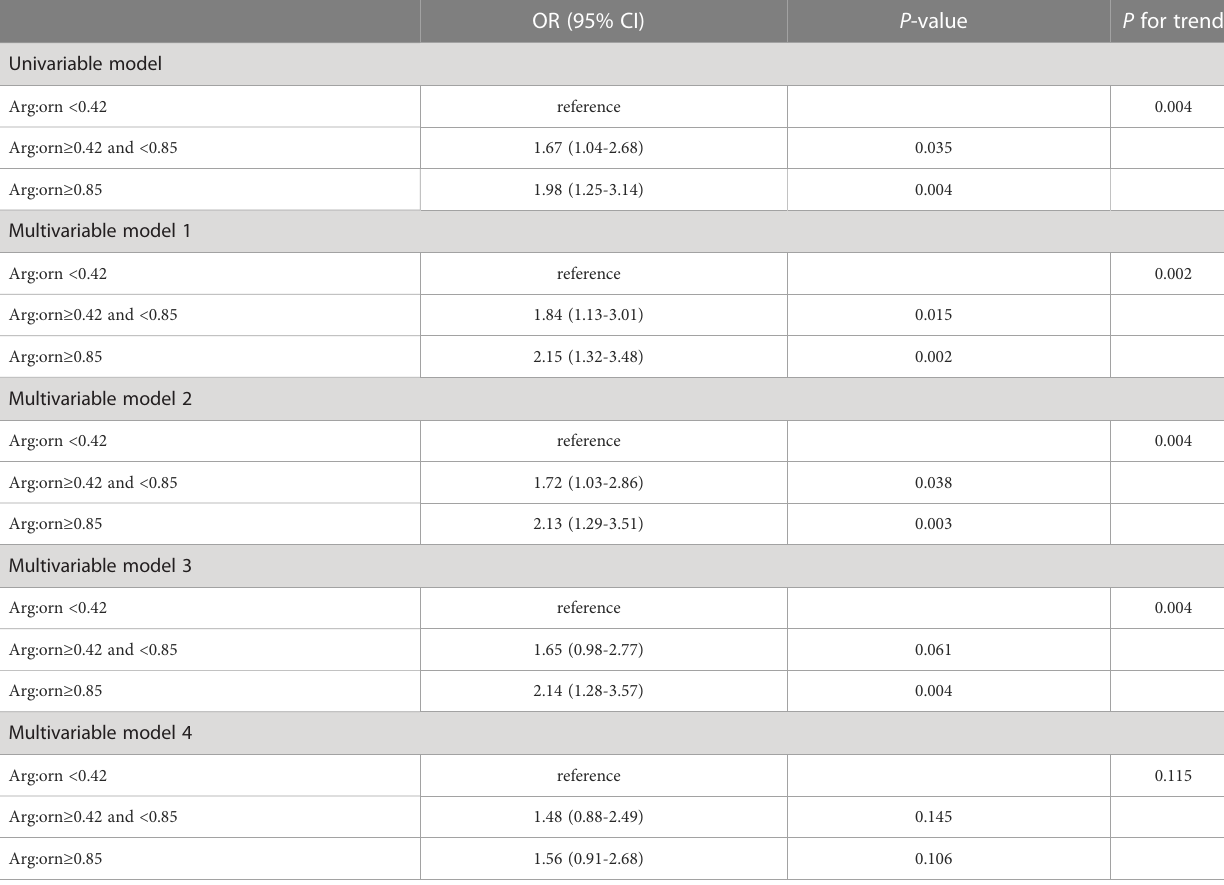
TABLE 5 Odds ratios of arg:orn for the risk of CKD.